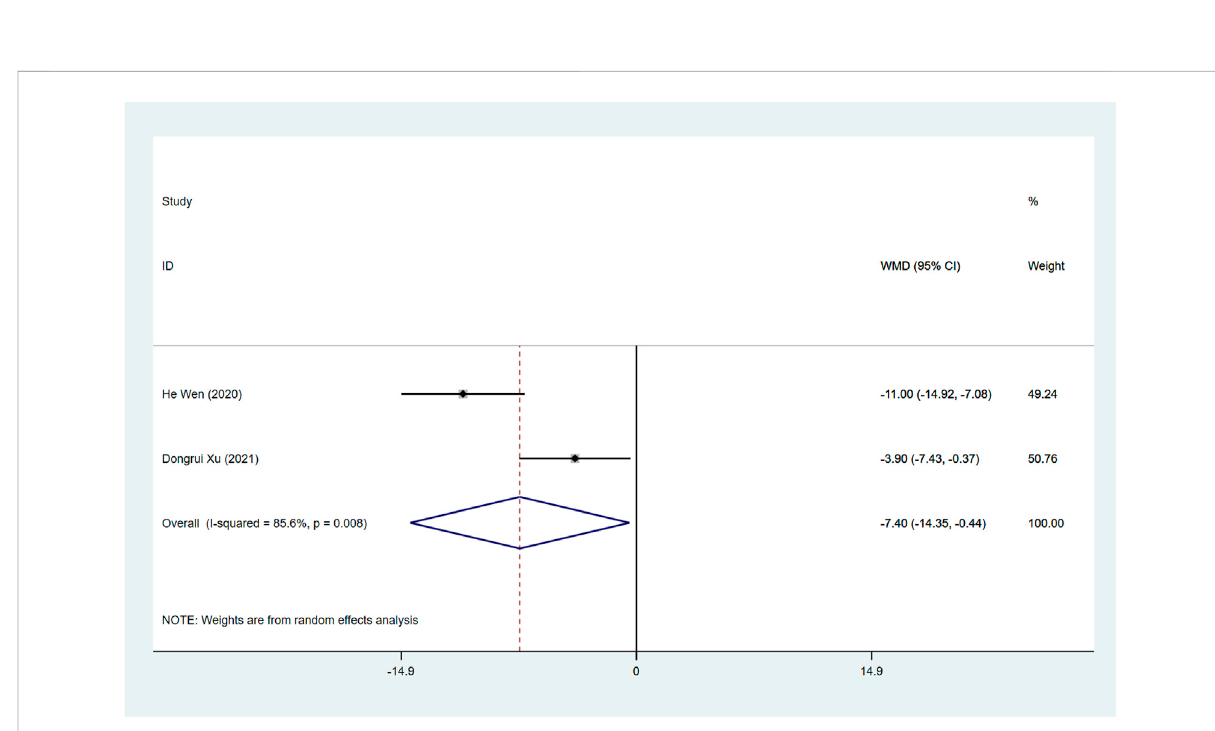
FIGURE 7 Forest plot of sST2 between sacubitril-valsartan and ACEI or ARB.